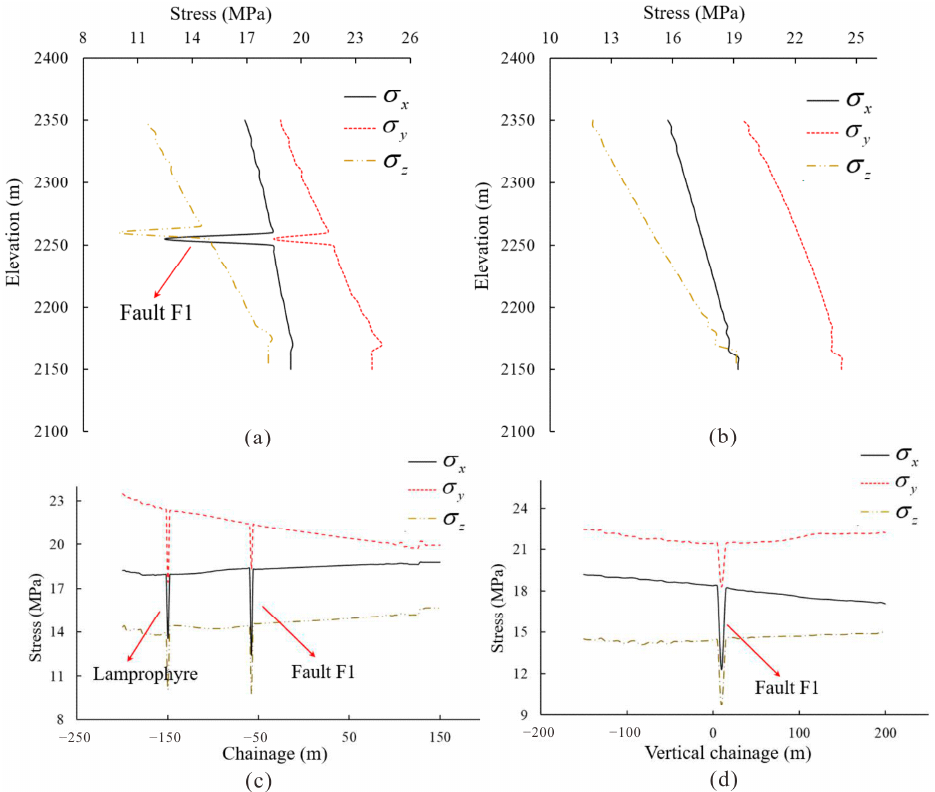
Figure 9. Stress variations along the depth ( a ) in the main powerhouse and ( b ) in the tailrace surge chambers; Stress variations in the plane of 2260 m elevation along the axis of the main powerhouse ( c ) and along the vertical axis of the main powerhouse ( d ).